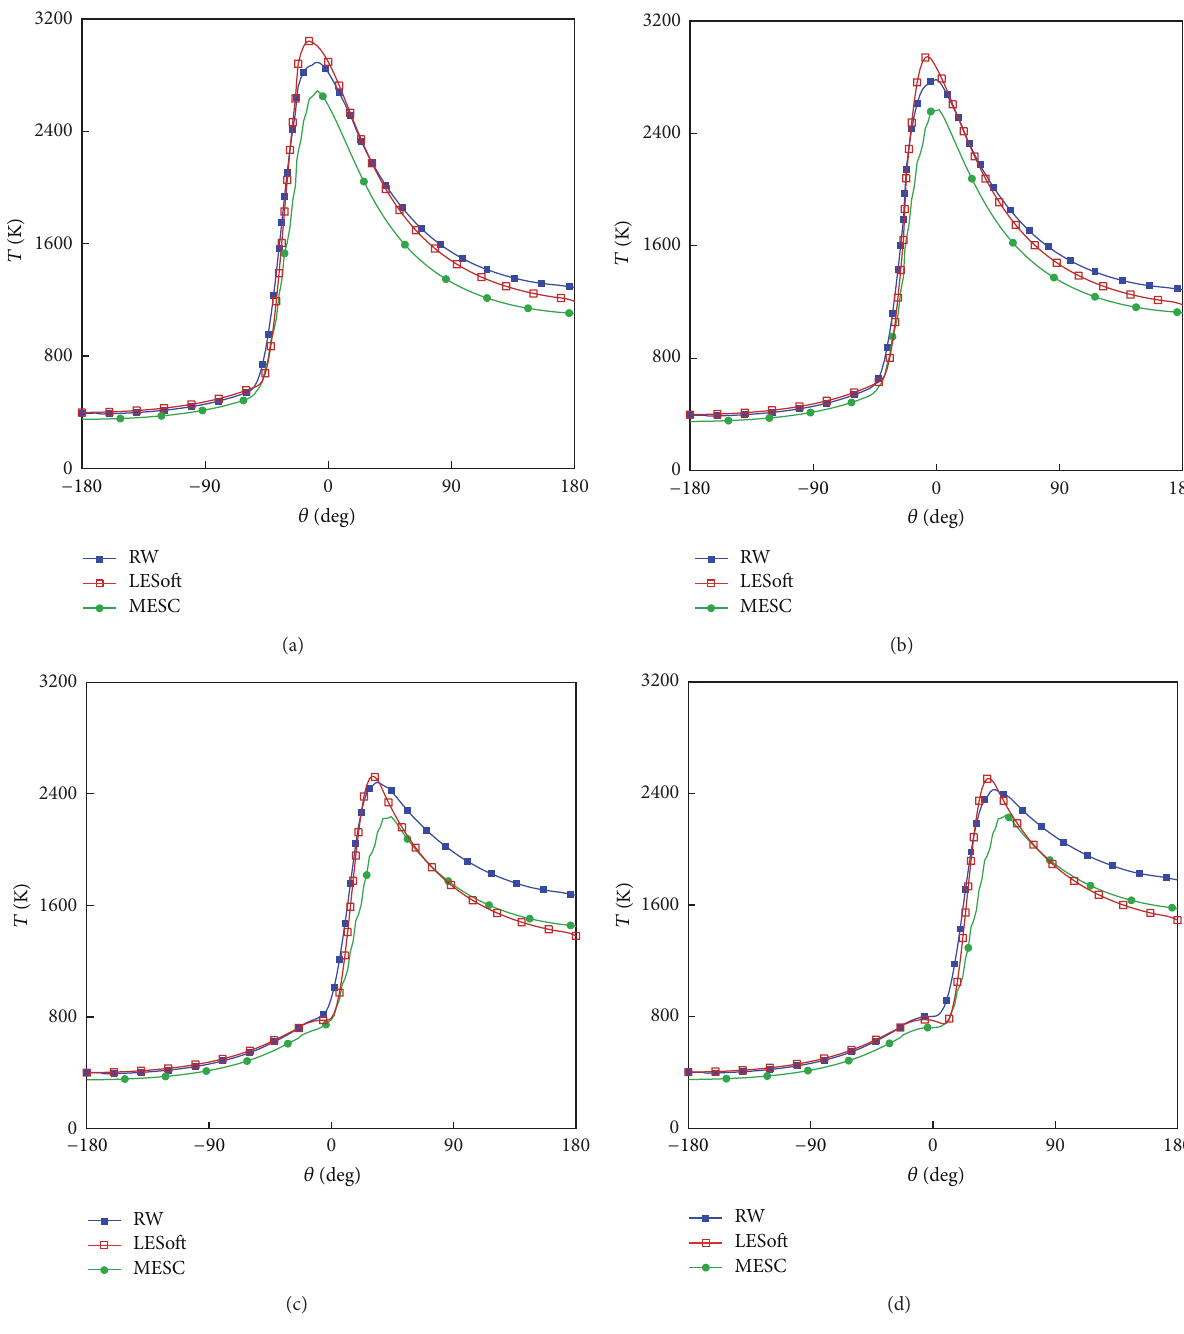
the corresponding crank angle. Those differences are caused by different assumptions on energy transfer in intake mani- fold and intake and exhaust